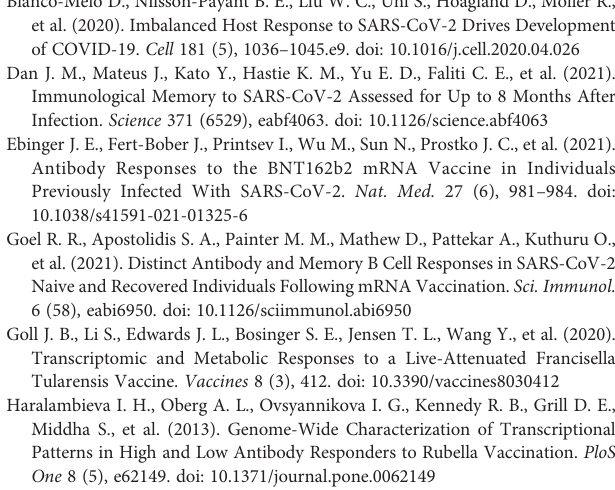
Supplementary Figure 1 | The standardization and fi ltering processes of gene expression. (A) The fi tting relationship between the average expression of unprocessed raw data (red line) and Sqrt. (B) The fi tting relationship between the average expression of normalized and fi ltered data (red line) and Sqrt. (C) The linear fi tting model constructed by Bayesian method. The horizontal blue line represents the average log2 residual standard